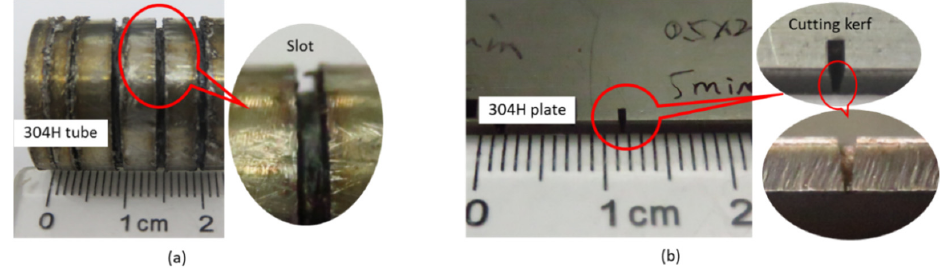
Figure 10. The results of cutting 304 stainless steel work-pieces: ( a ) the result of kilowatt fiber laser cutting of tube; ( b ) the result of 500-femtosecond pulse laser cutting of plate.